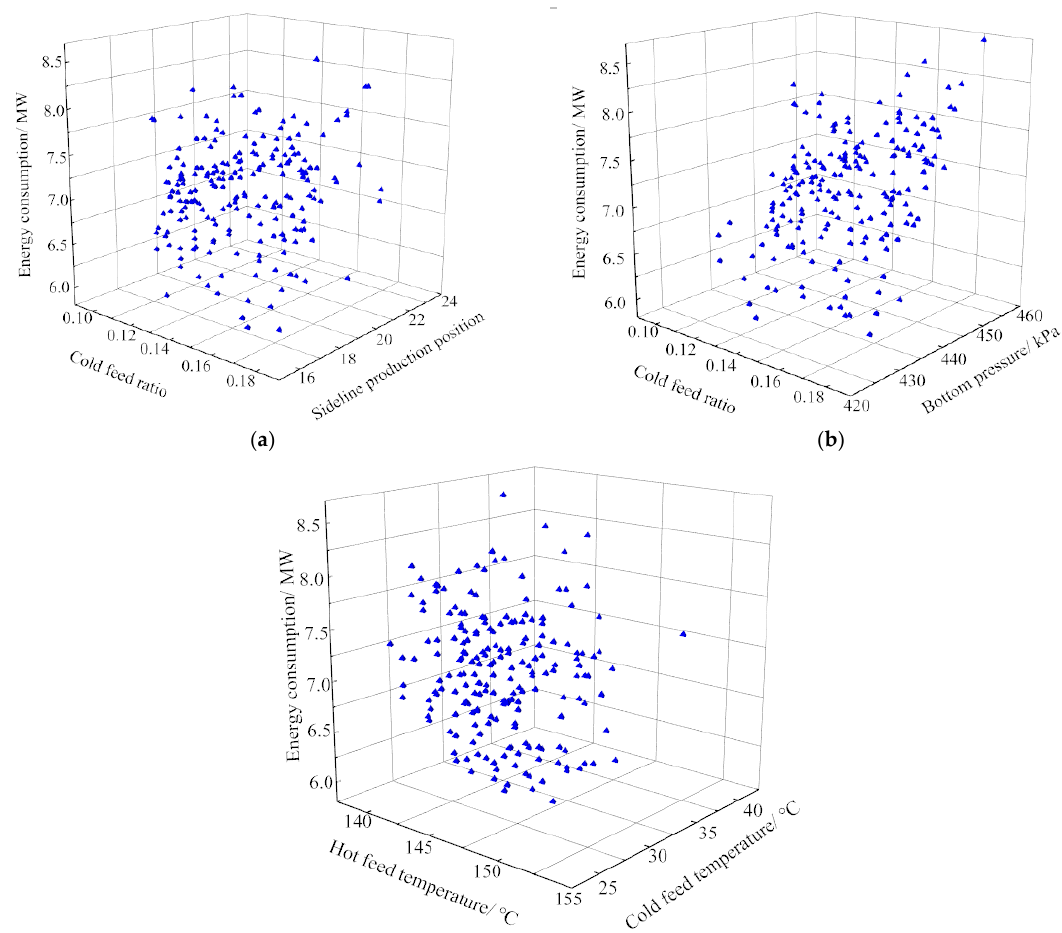
Figure 4. The blue triangles in Figure 4. represent sample points of corresponding system energy consumption under different operating conditions.